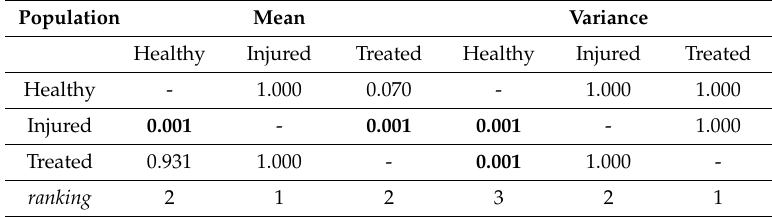
Table 5. Mean-based (test on location) and variance-based (test on scatter) permutation one-sided p -values for pairwise comparisons among populations and related ranking results. In each row the p -value refers to the comparison between the population in row vs. the population in column (hypotheses: population in row = population in col. vs. population in row > population in col.). The 1% significant p -values are highlighted in bold (since we jointly considered both one-sided alternatives, the actual α -level must be α / 2). p -values were adjusted by multiplicity using the Bonferroni–Holm–Sha ff er method